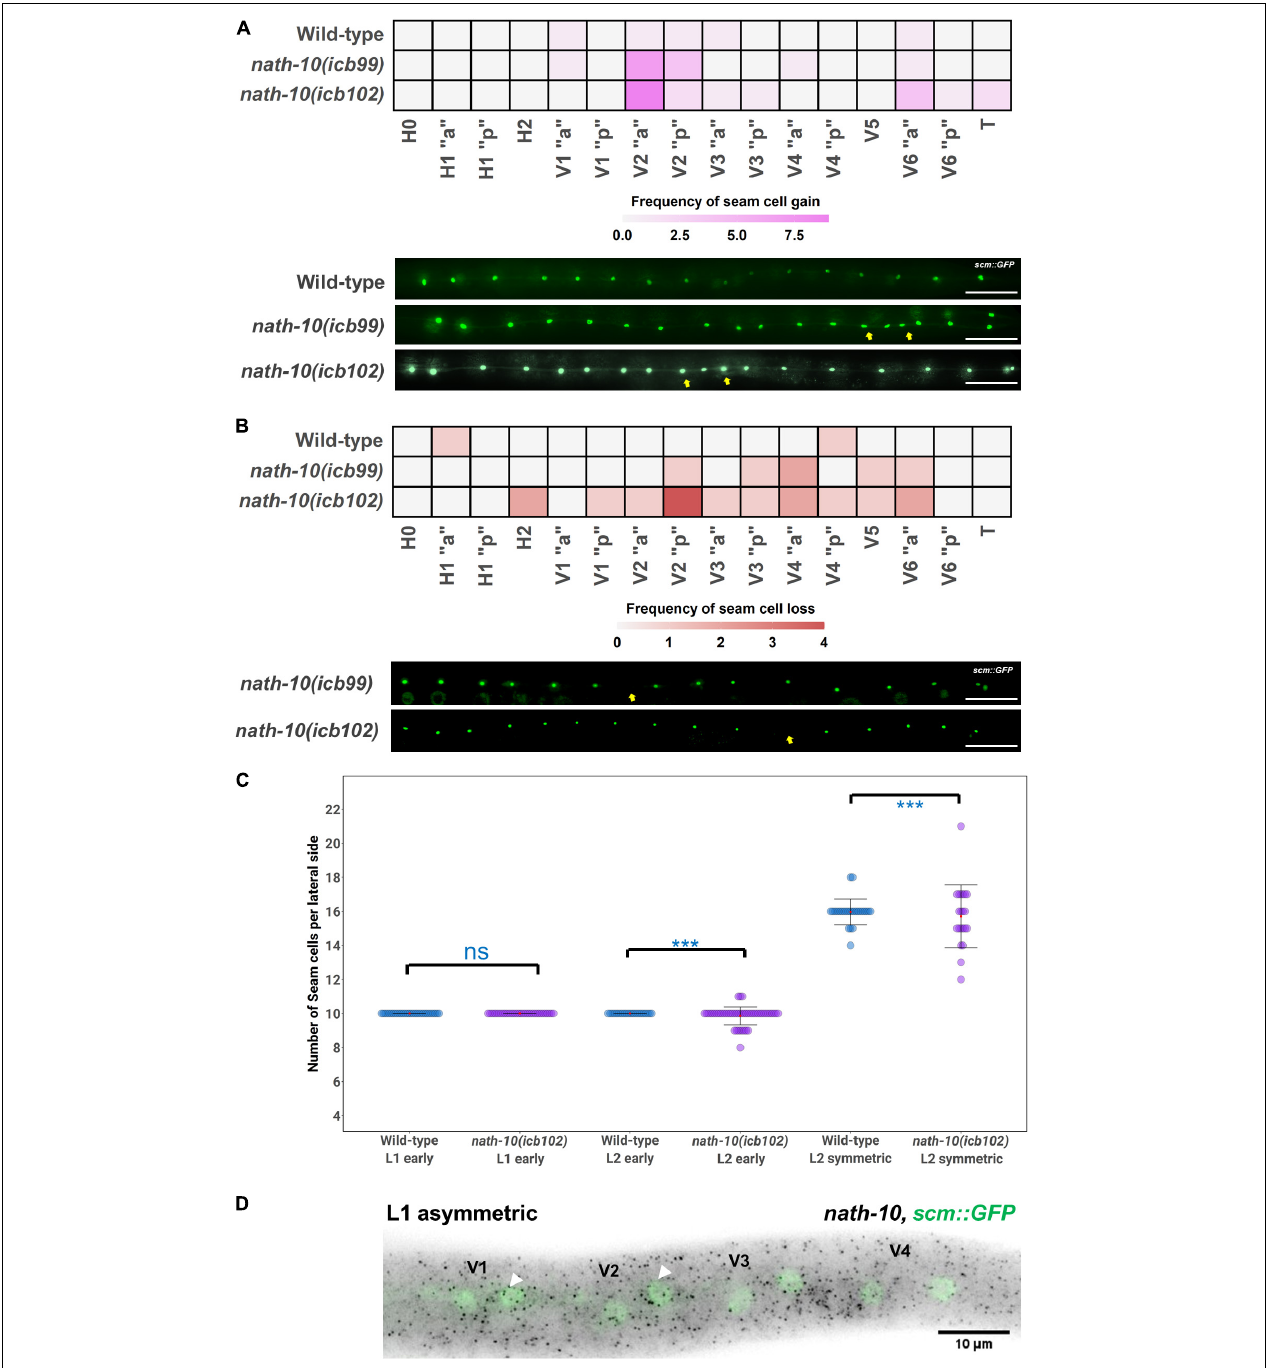
FIGURE 2 | nath-10 loss-of-function causes both gains and losses of seam cells from the early L2 stage. (A) Heat map displaying frequency of seam cell duplications for wild type, nath-10(icb99) and nath-10(icb102) . Increased seam cell duplication frequency occurs mostly in the V2 seam cell. Representative images below from wild type, nath-10(icb99) and nath-10( icb102) animals carrying the scm::GFP transgene. Yellow arrows indicate seam cell duplications. (B ) Heat maps displaying seam cell losses in nath-10 mutants. Note that losses are found more frequently in the V lineage seam cells. Yellow arrows indicate missing seam cells. In (A,B) , “a” and “p” represent the anterior and posterior branch of a seam cell lineage. (C) Seam cell counts at early L1, early L2 and mid L2 stage for wild type and nath-10(icb102) mutants. No difference was found at the early L1 stage as, all animals’ hatch with 10 seam cells, whereas a significant difference in variance of seam cell number was found at the L2 stage (Levene’s test *** p < 0.001). (D) Representative image of nath-10 smFISH shows expression in seam cells at the time errors begin to occur (L1 division). White arrowheads point to posterior daughter cells following the L1 asymmetric division. Nuclei are labeled green because of s cm::GFP expression. Scale bars in (A,B) indicate 100